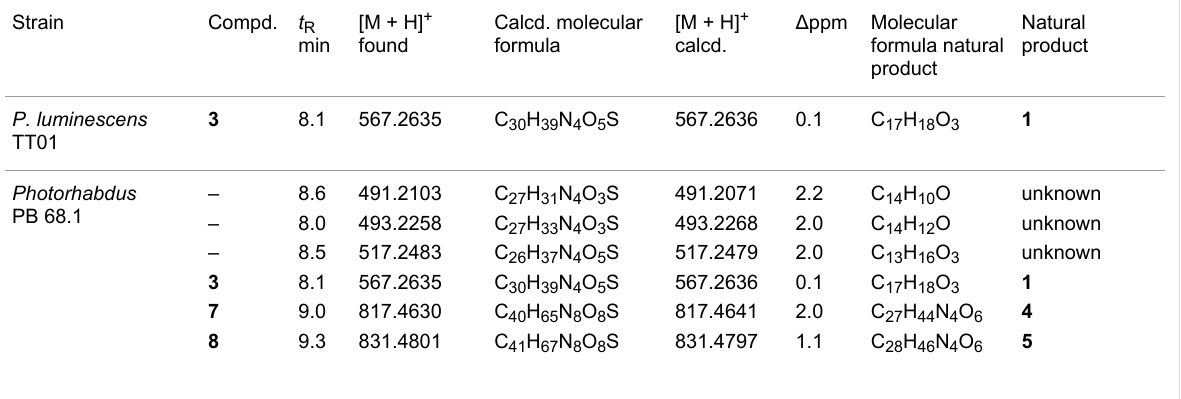
Table 1: Additionally found masses in the tested strains, calculated molecular formulas of possible azide–alkyne cycloaddition products, and the mo- lecular formulas of the putative parent compounds derived from subtraction of the azide and CARR-derived moiety (C 13 H 19 N 4 O 2 S). Strain